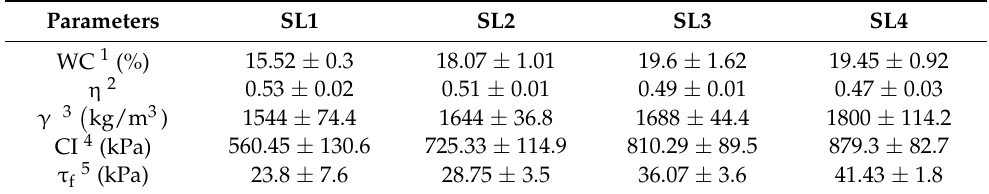
Table 4. Results of measurement of soil properties according to soil layers in sandy loam (first site). Parameters